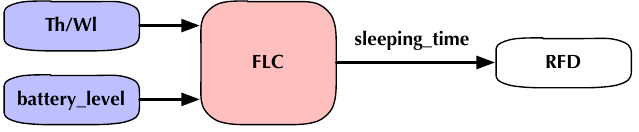
Figure 2. The proposed FLC